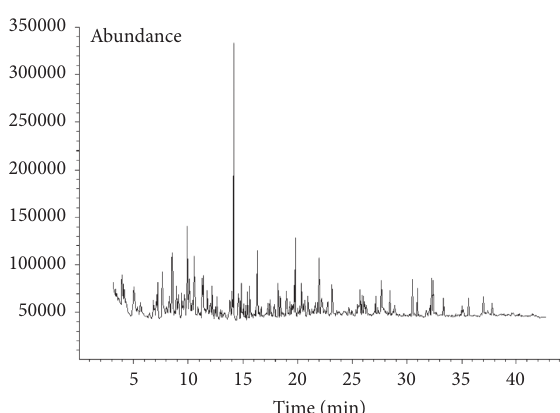
Figure 3: Total ion flow chromatogram of components in